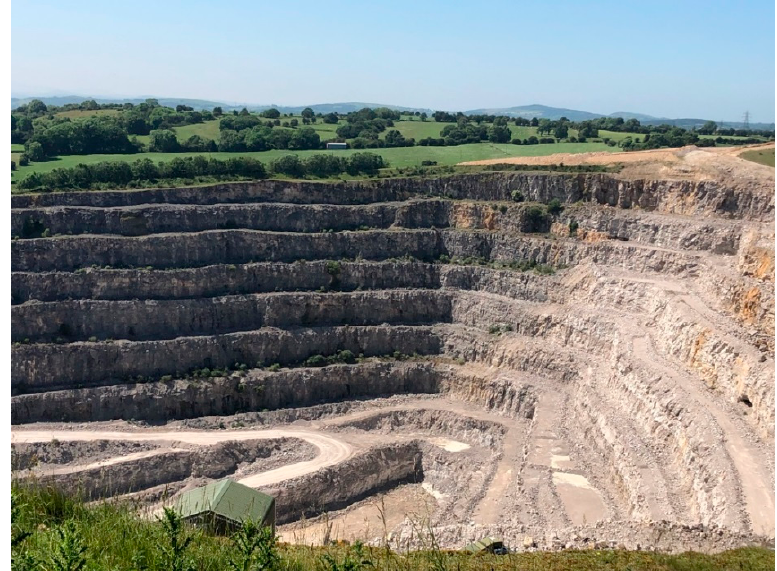
Figure 3. Pant-y-Pwll-Dwr limestone quarry, Halkyn Mountain. Photo © Mark Nuttall.